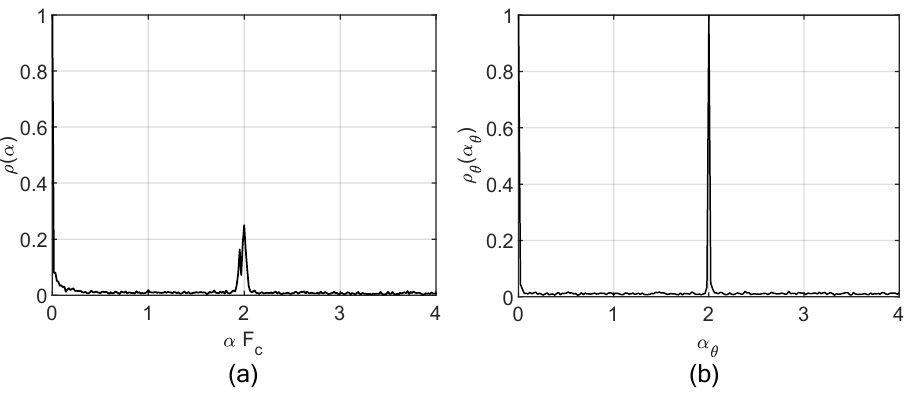
Figure 2. Alpha profile ( a ) and alpha-angle profile ( b ) calculated for a AM-DSB-FC signal with nonlinear phase over